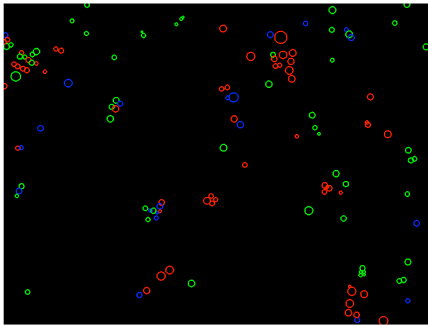
Figure 13. Red blue and green marks show changes detected